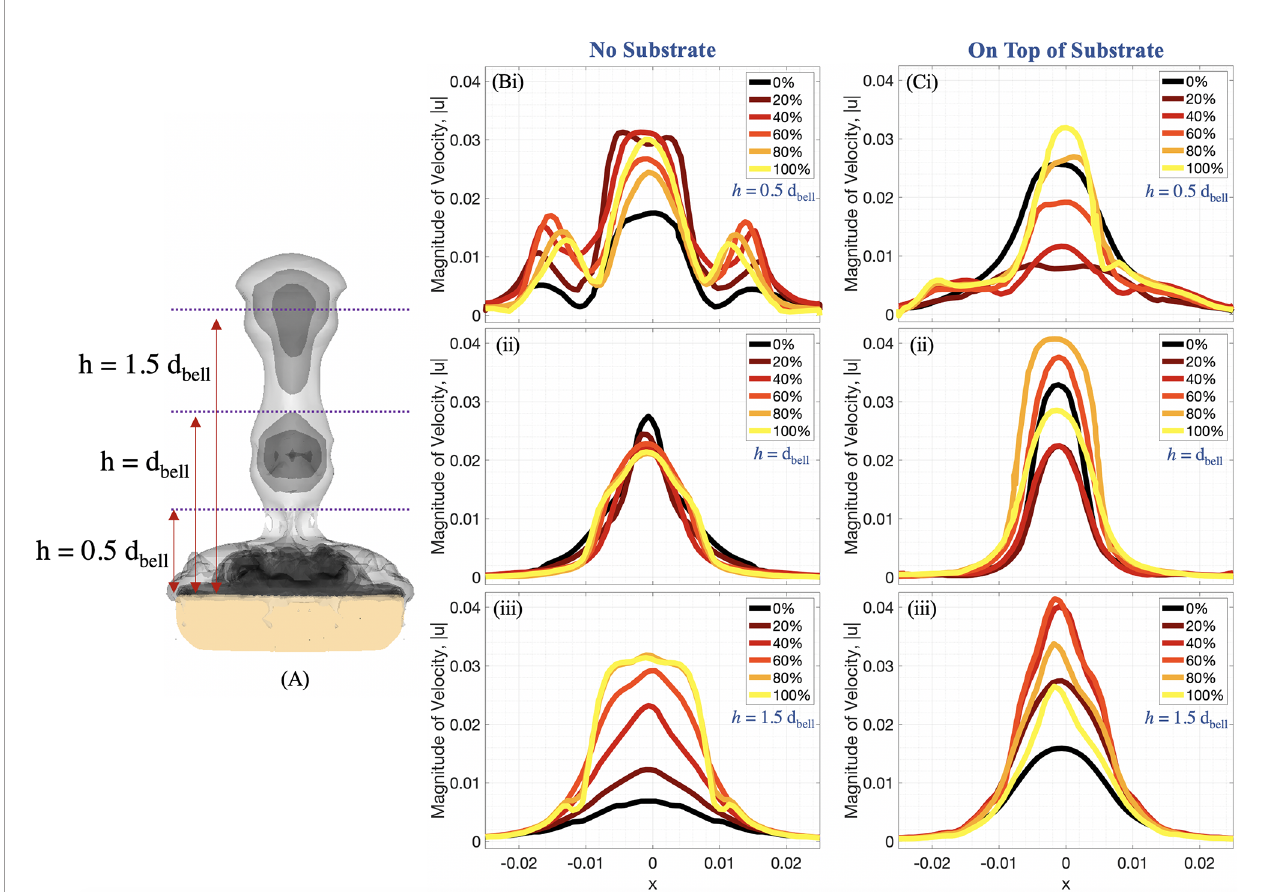
FIGURE 9 | (A) Radial distribution of 3D velocity magnitude (in units of m s -1 ) obtained from numerical simulations, computed along horizontal lines above the bell with (B) no substrate and (C) sitting on a substrate. The horizontal lines are drawn at distances of (i) 0.5 d bell , (ii) d bell , and (iii) 1.5 d bell above the bell. Each plot provides data during the fourth pulsation cycle at 0%, 20%, 40%, 60%, 80%, and 100% of the cycle. All distances are in units of